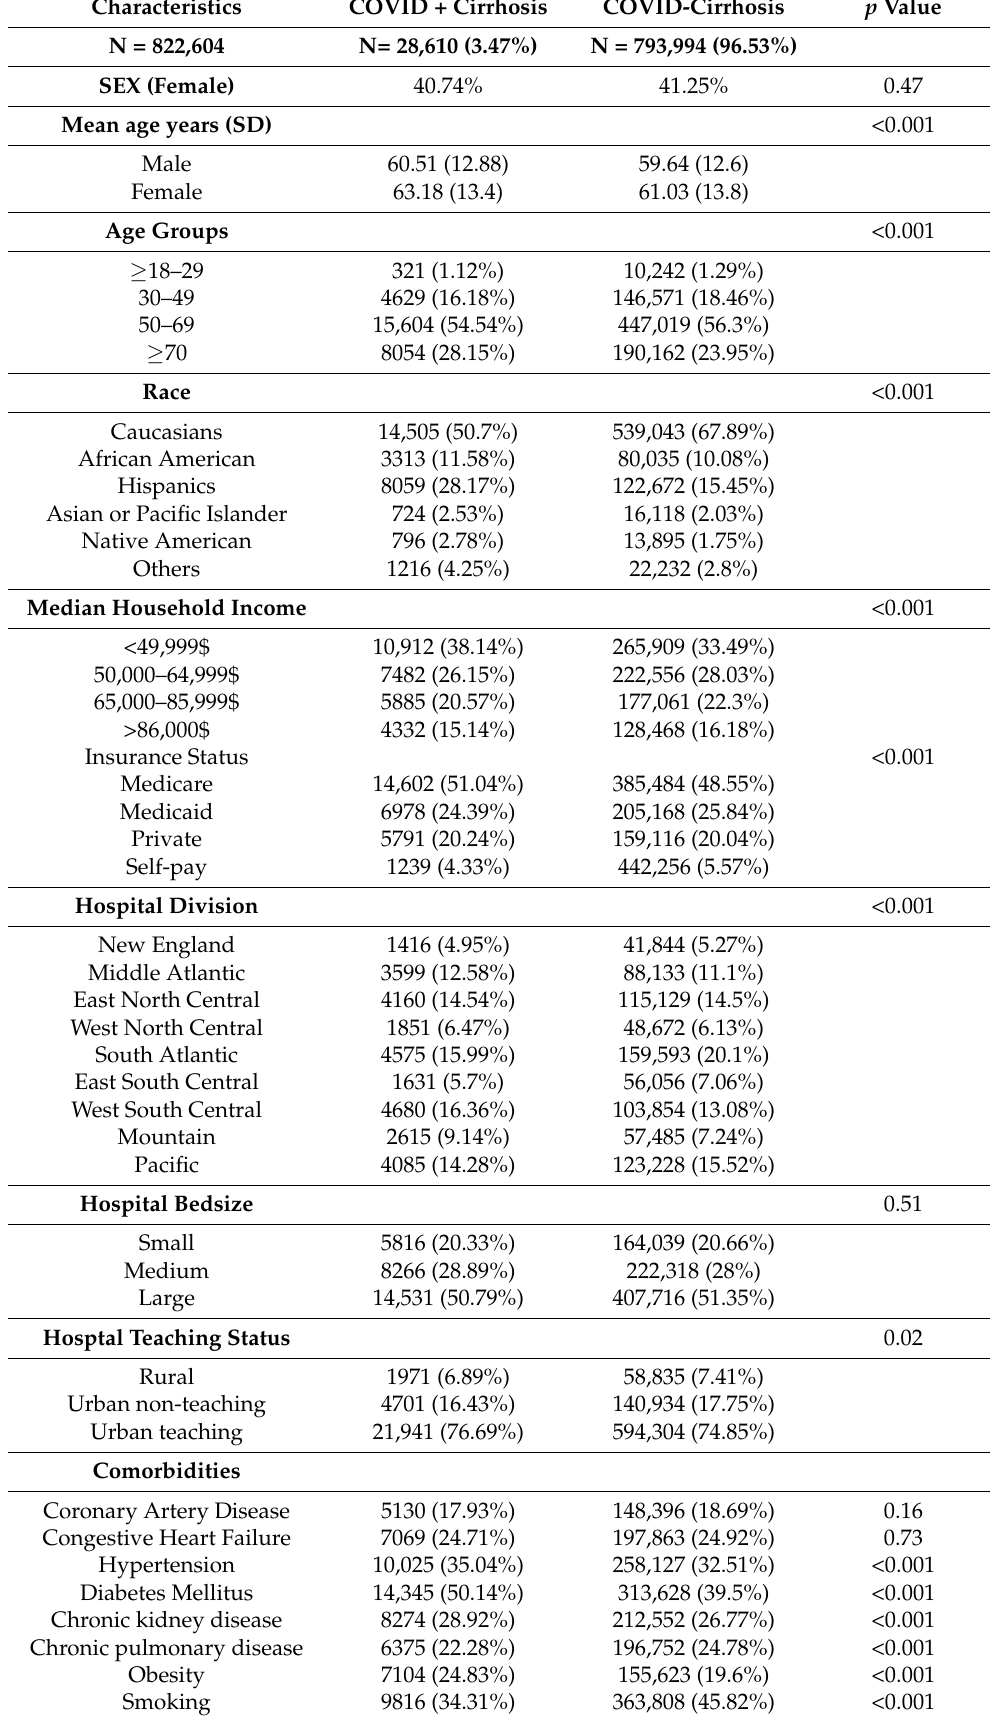
Table 1. Cirrhosis and COVID-19 patient-level